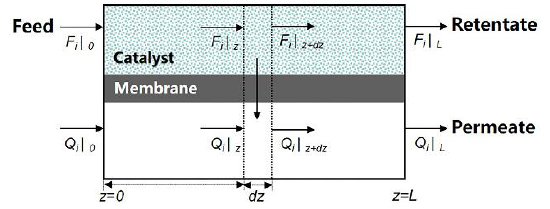
Figure 1. Schematic model for the membrane reactor simulation.